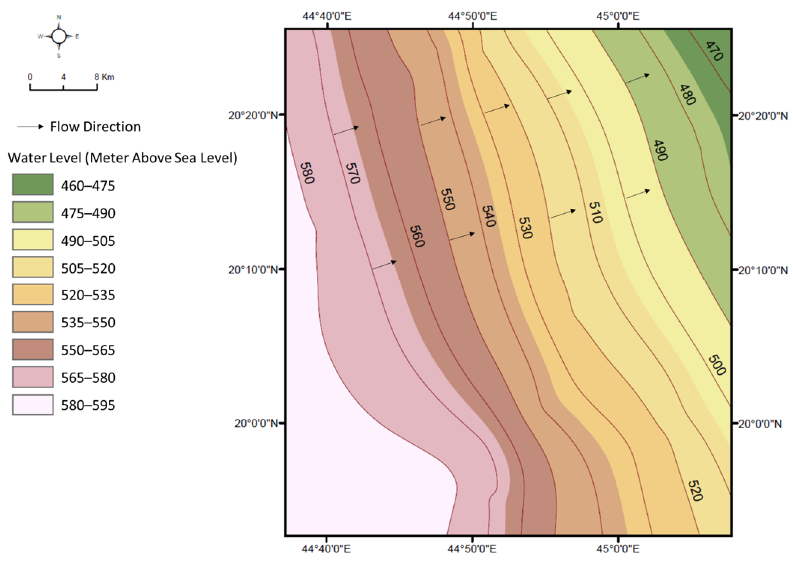
Figure 4. Groundwater level contour map of the Wajid aquifer.